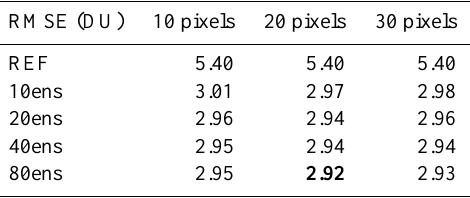
Table 1. Root mean square error (expressed in DU) calculated for the sensitivity tests performed on 17, 18 and 19 July 2007. Tests of ensemble sizes are presented in different rows, maximum local patch sizes (10, 20 and 30 pixels) in different columns. The first row of the table shows the root mean square error calculated for a reference run “without assimilation” (REF). The lowest value of the RMSE is highlighted in bold. RMSE (DU) 10 pixels 20 pixels 30 pixels REF